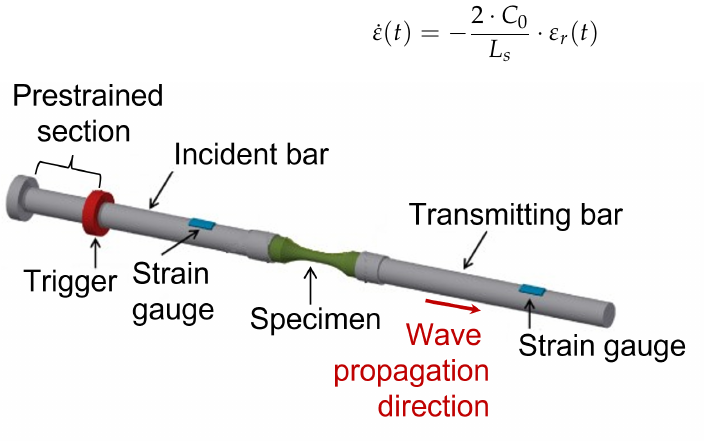
Figure 2. DT-Hopkinson bar system schematic